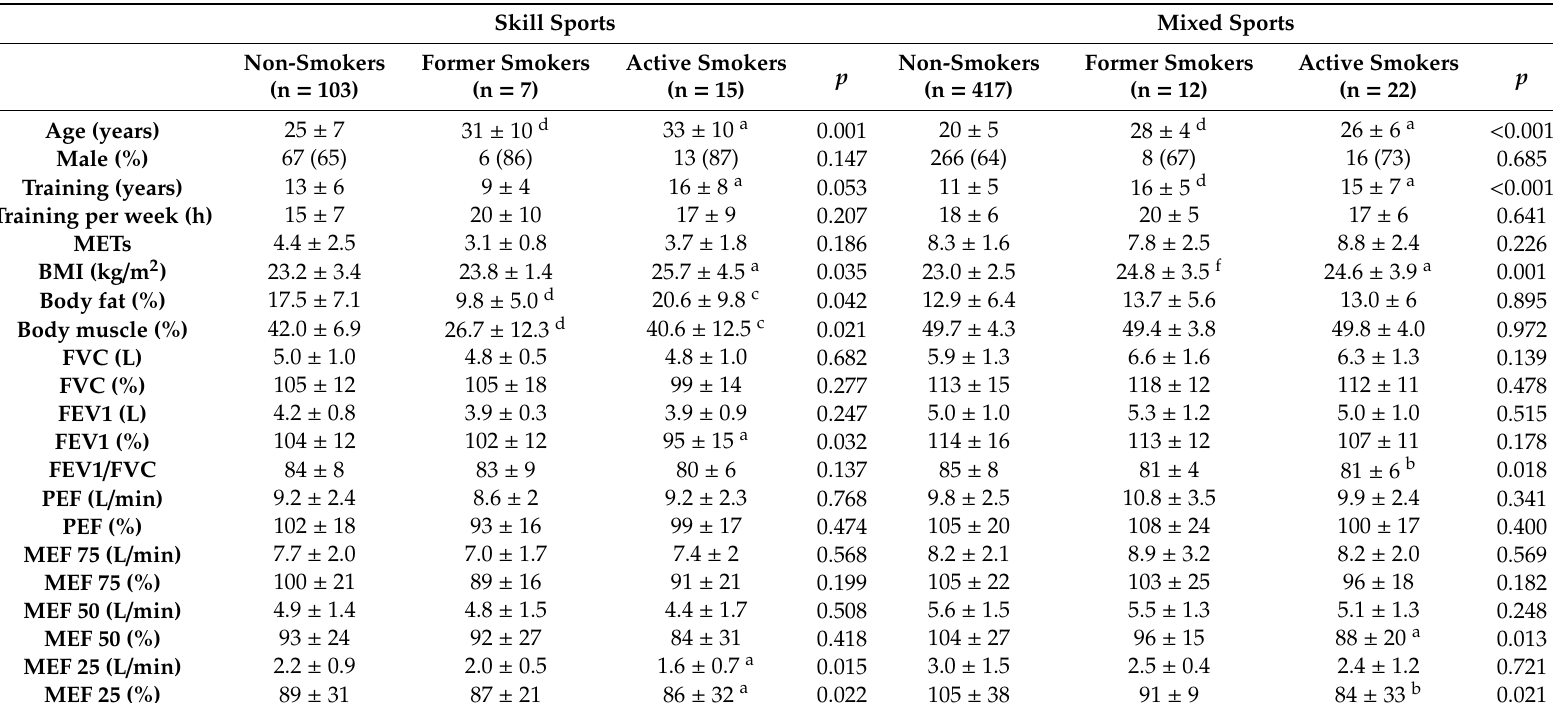
Table 3. Demographic characteristics and clinical parameters in the athletes in skill and power sports